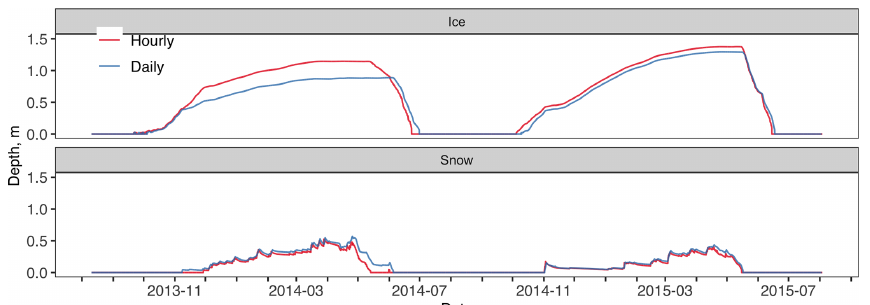
Figure F4. Atqasuk ice and snow depth across different temporal resolution simulations. No observed data are available, hourly temporal resolution is in red, and daily temporal resolution is in blue.